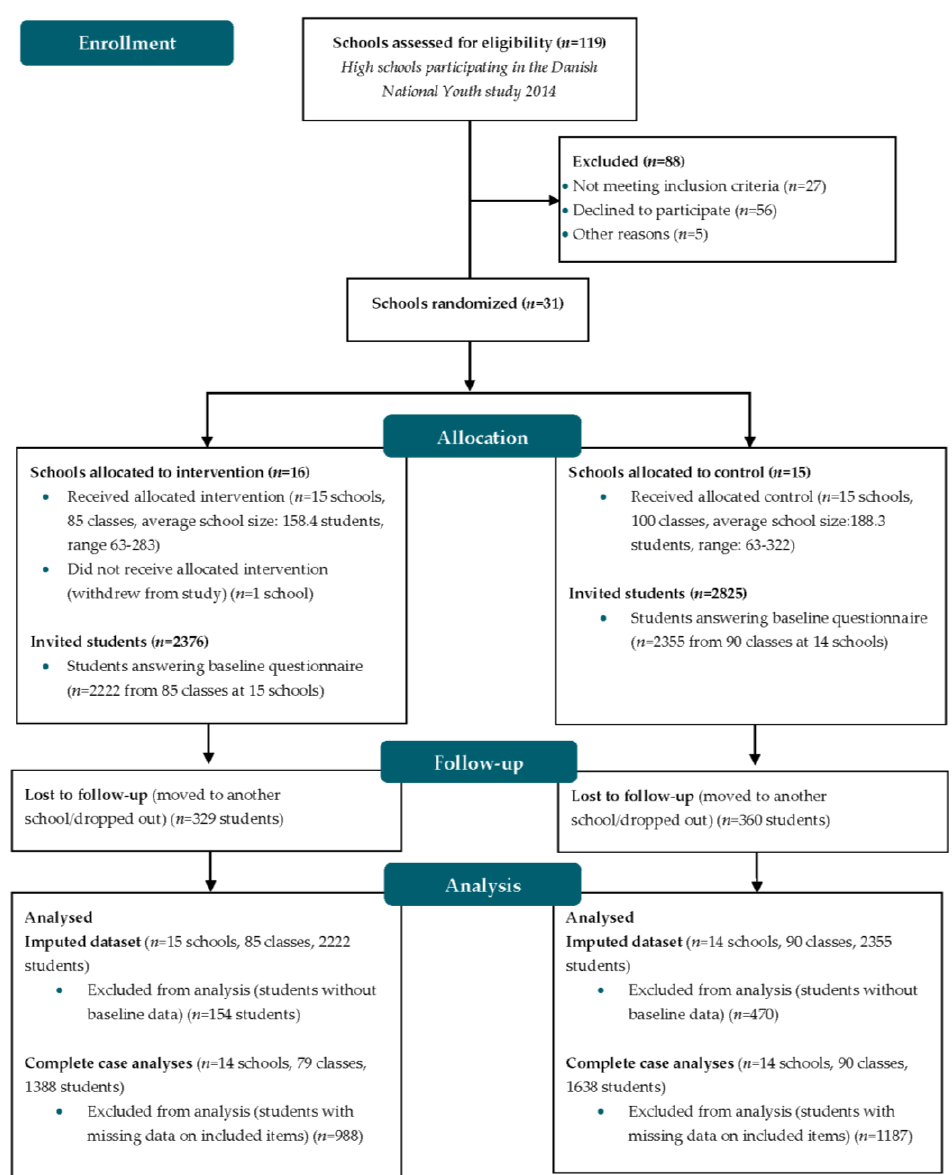
Figure 1. Flow diagram of schools and students in the Healthy High School Study.